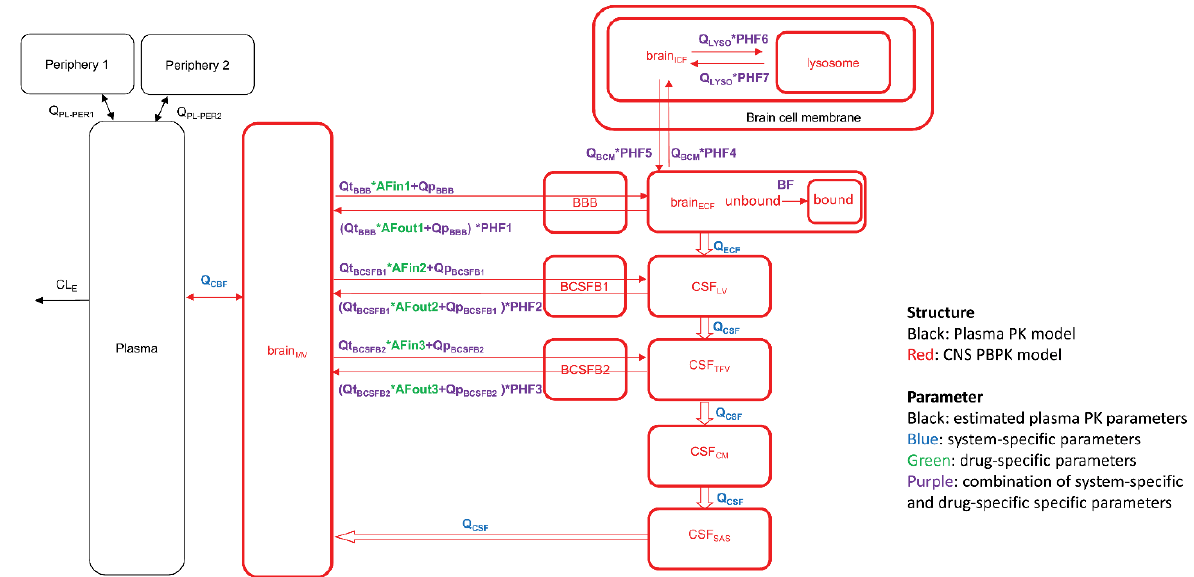
Figure 6. The model consists of a plasma pharmacokinetic (PK) model and a central nervous system (CNS) physiologically based pharmacokinetic (PBPK) model with estimated plasma PK parameters, and system-specific and drug-specific parameters (colors) for CNS. Peripheral compartments 1 and 2 are used when required to describe the plasma data adequately by a plasma PK model. AFin1–3, asymmetry factor into the CNS compartments 1–3; AFout1–3, asymmetry factor out from the CNS compartments 1–3; BBB, blood-brain barrier; BCSFB, blood-cerebrospinal fluid barrier; BF, binding factor; brainECF, brain extracellular fluid; brain ICF , brain intracellular fluid; brain MV , brain microvascular; CSF CM , cerebrospinal fluid in the cisterna magna; CSF LV , cerebrospinal fluid in the lateral ventricle; CSF SAS , cerebrospinal fluid in the subarachnoid space; CSF TFV , cerebrospinal fluid in the third and fourth ventricle; PHF1–7, pH-dependent factor 1–7; Q BCM , passive diffusion clearance at the brain cell membrane; Q CBF , cerebral blood flow; Q CSF , cerebrospinal fluid flow; Q ECF , brain ECF flow; Q LYSO , passive diffusion clearance at the lysosomal membrane; Qp BBB , paracellular diffusion clearance at the BBB; Qp BCSFB1 , paracellular diffusion clearance at the BCSFB1; Qp BCSFB2 , Qt BCSFB1 , transcellular diffusion clearance at the BCSFB1; Qt BCSFB2 , transcellular diffusion